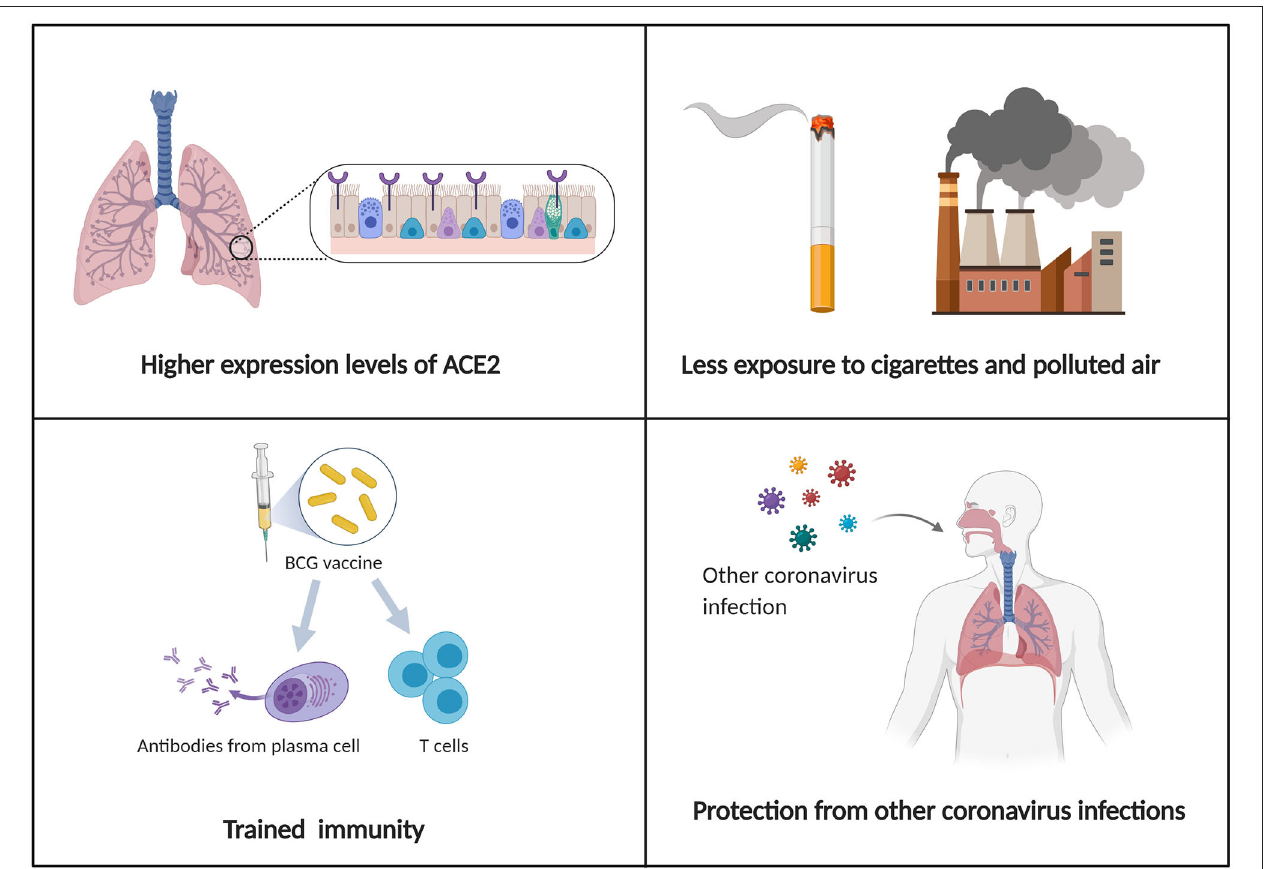
FIGURE 1 | Schematic illustration of possible mechanisms for explaining why children have milder symptoms and a better prognosis than adults.